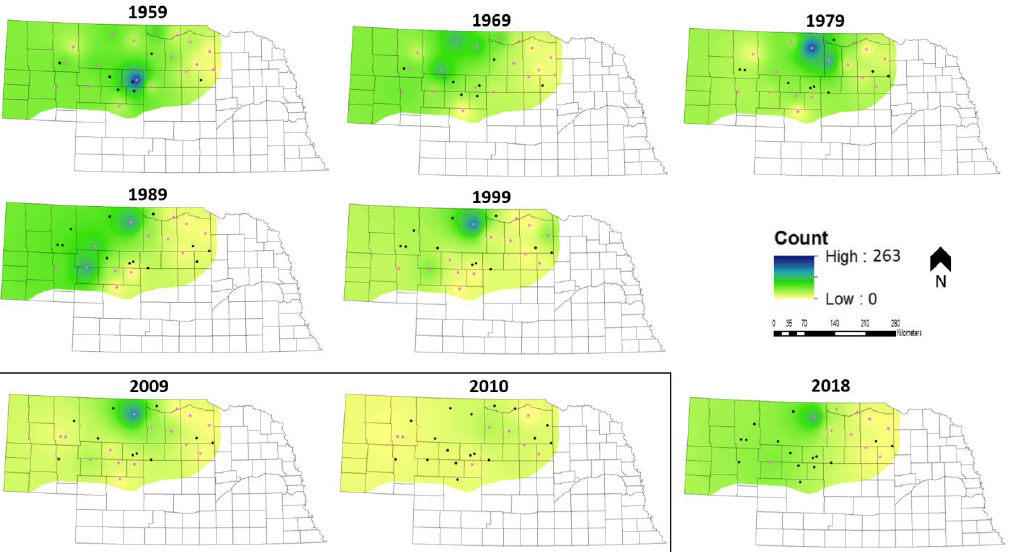
Figure 7. Sharptail inverse distance weighted spatial population trends at decadal intervals from 1959 to 2018 in the Sandhills of Nebraska, USA. Pink route midpoints indicate that data were collected at that location in a given year. The two adjacent years encompassed within the black box were included to illustrate the effect of changing the subset of monitored routes between years when little change in population distribution has likely occurred. The time series ends in 2018 with the last year of available